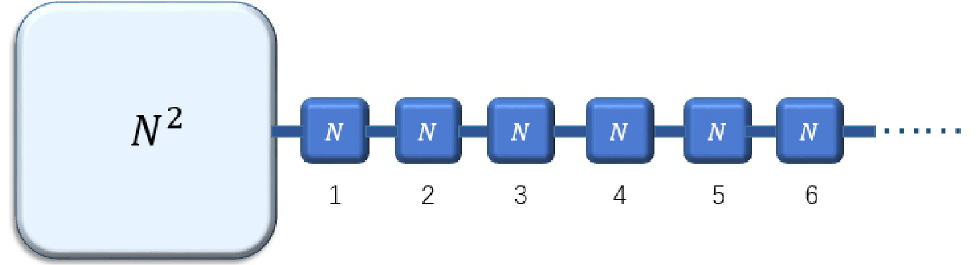
Figure 7 . A pictorial representation of the model discussed in section 3.2: an SYK chain with N fermions each site in contact with a SYK system with N 2 fermions on one